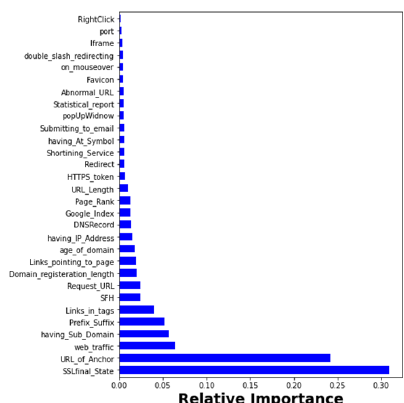
Fig. 6. Using Permutation Importance from eli5.sklearn, extracting the top features for the dataset